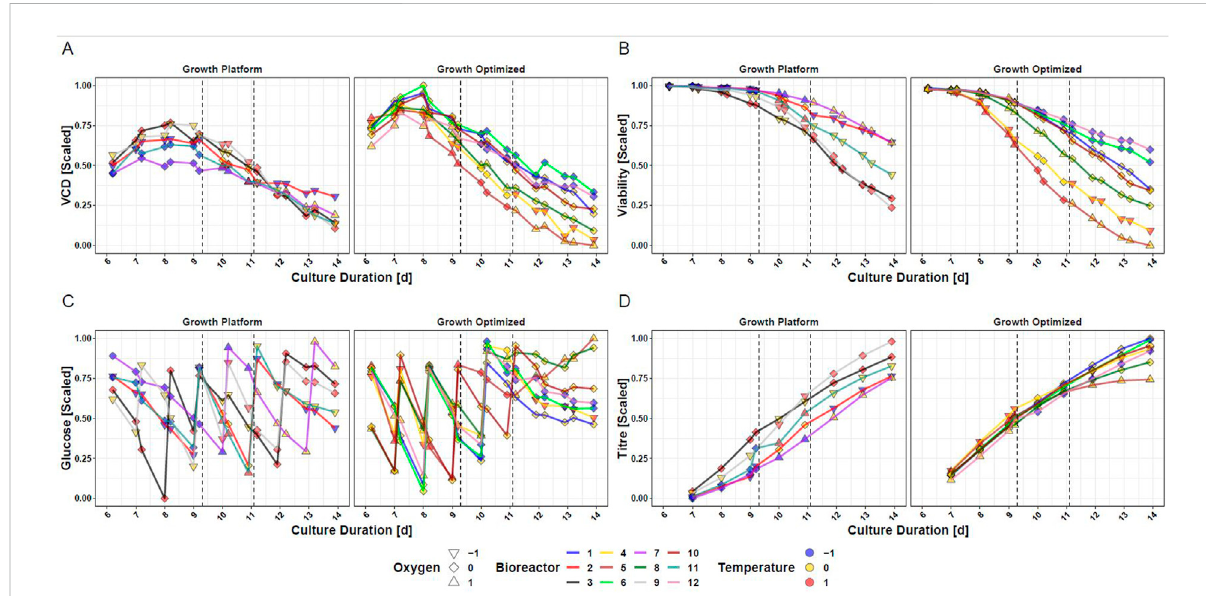
FIGURE 2 Cultured Mammalian Cells Show Different Trajectories for Measured Outputs in the Fed-Batch Process Dependent on the Input Parameter Setpoints of DO and Temperature. (A) VCD (B) Viability (C) Glucose (D) Titer. Dependent on the input parameter settings the cells were exposed to during the growth phase from day 0 – 6, the data of the bioreactors is separated into growth optimized and growth at platform